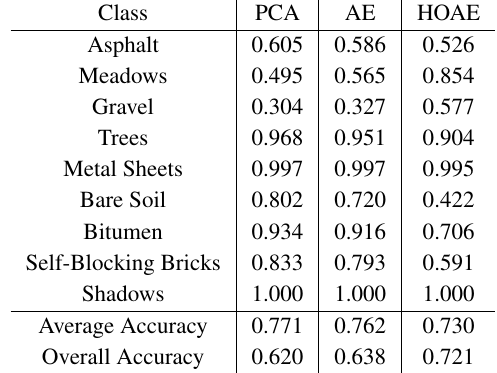
Table 3. Summary of the producer, average, and